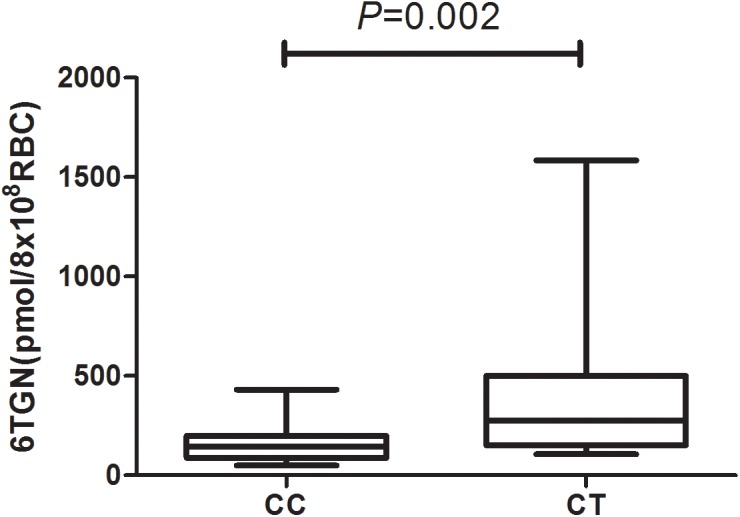
6-Thioguanine nucleotide concentrations for patients with rs116855232 CC and CT genotypes were 145.3(87.4, 199.0) pmol/8 ∗108 RBC and 276.6(150.9, 501.0) pmol/8∗108 RBC, respectively (P = 0.002).